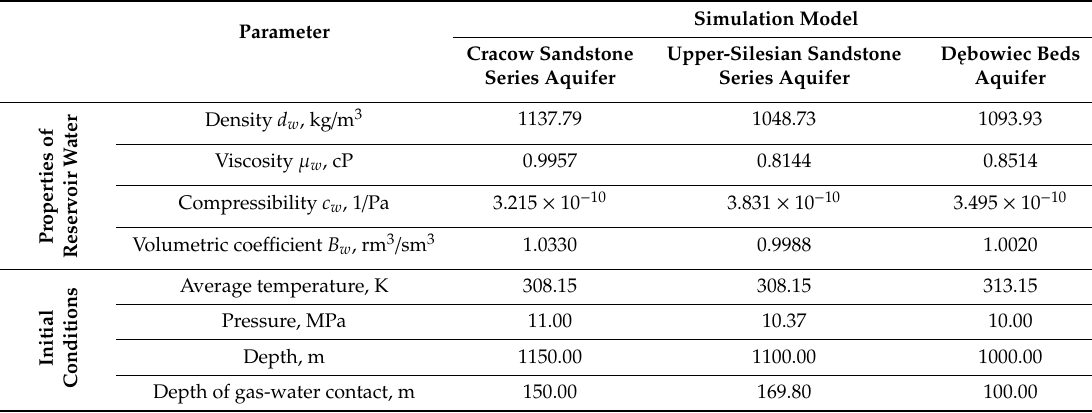
Table 4. Characteristics of the initial conditions in the simulation